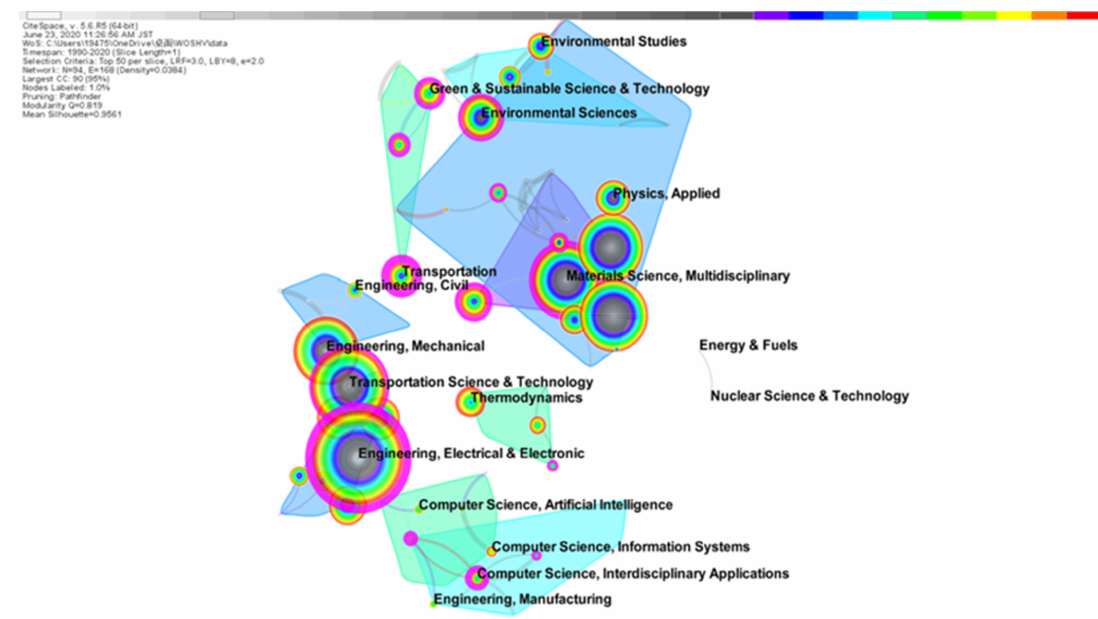
Figure 5. Main research categories of HVs and PHVs.